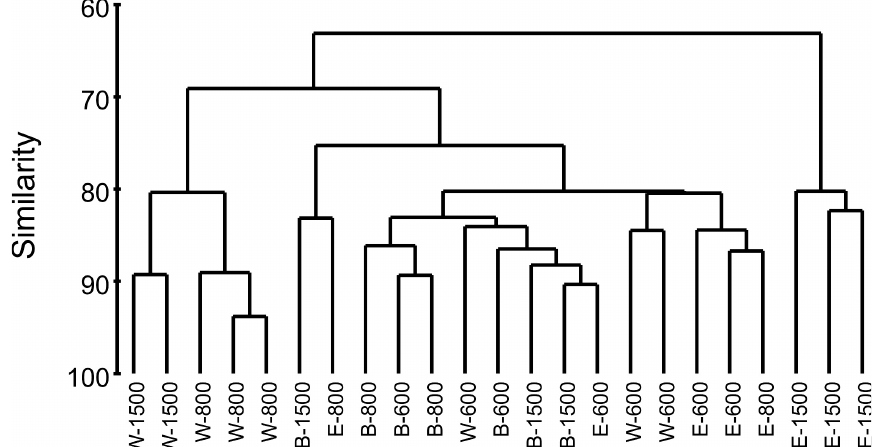
F IG . 6. – Bray-Curtis similarity dendrogram from square root transformed abundances. Letters refer to the sub-basins and numbers to station depth. B, Balearic; W, Western Ionian; E, Eastern Ionian.